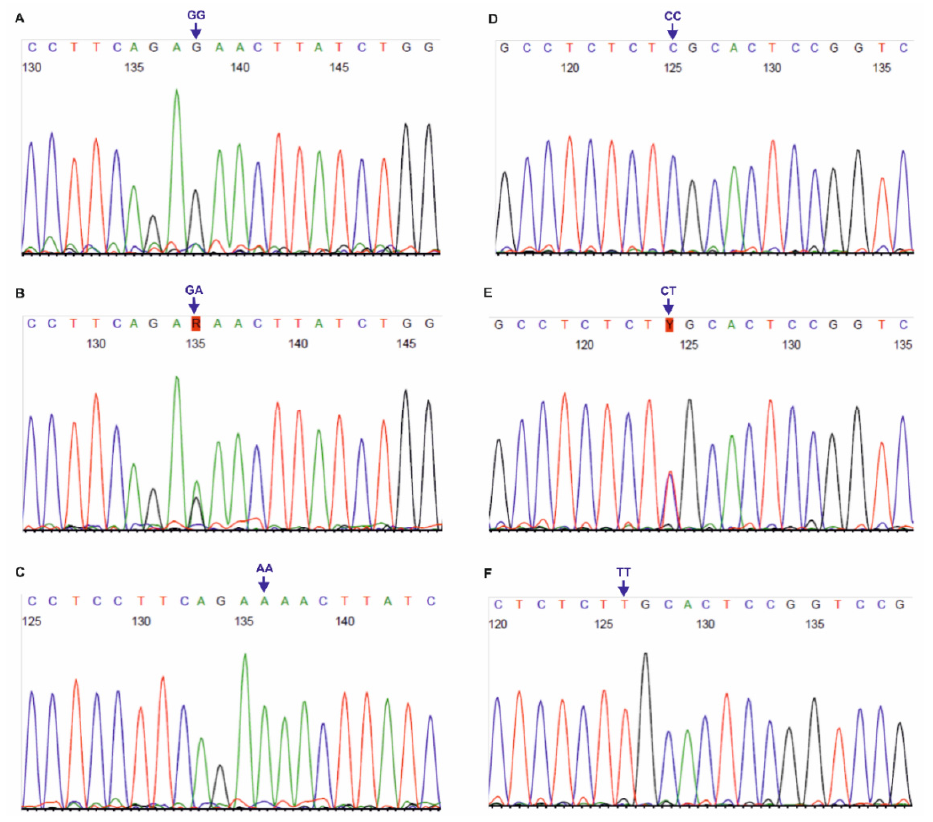
Figure 2. Chromatograms of DNA forward strands for DLX3 rs11656951 ( A – C ) and rs2278163 ( D – F ) SNPs. AA, CC, CT, GA, GG, TT: genotypes in the tested polymorphisms.